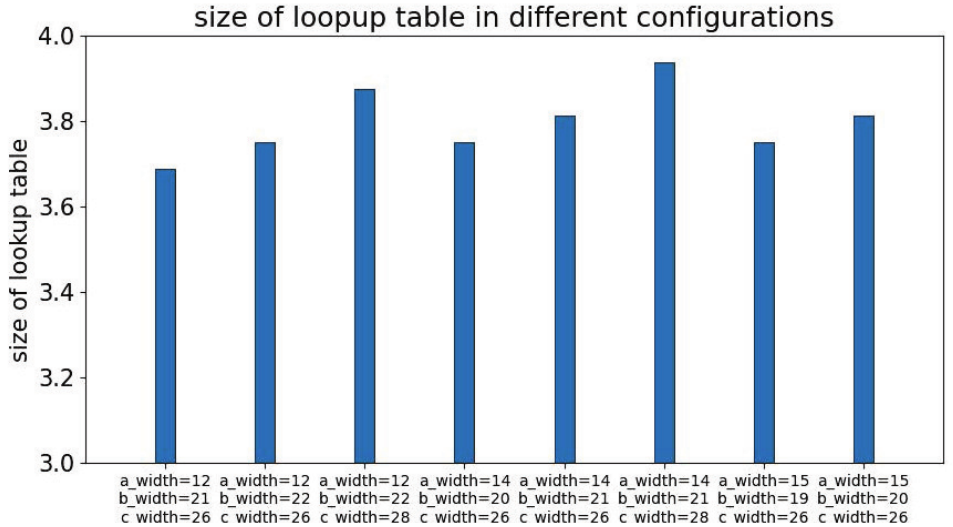
Figure 5. The relationship between the size of the lookup table and the different